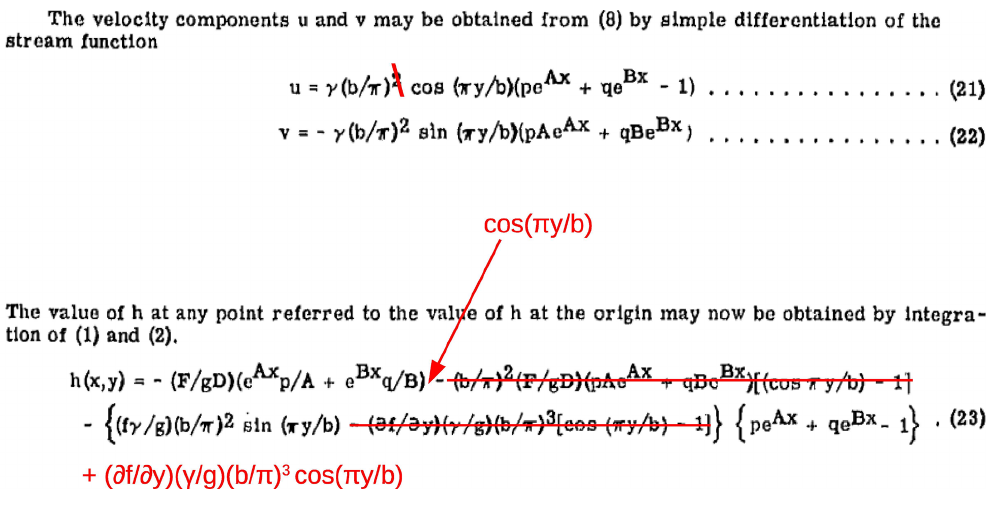
Figure A1. Corrections to u and h indicated over excerpts from Stommel